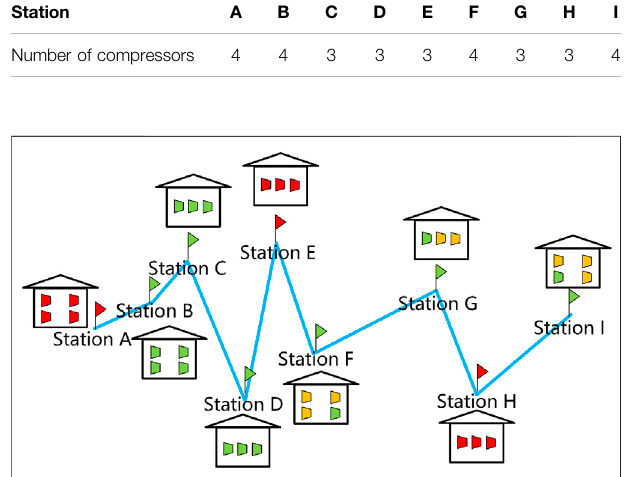
FIGURE 4 | Schematic diagram of compressor working status on